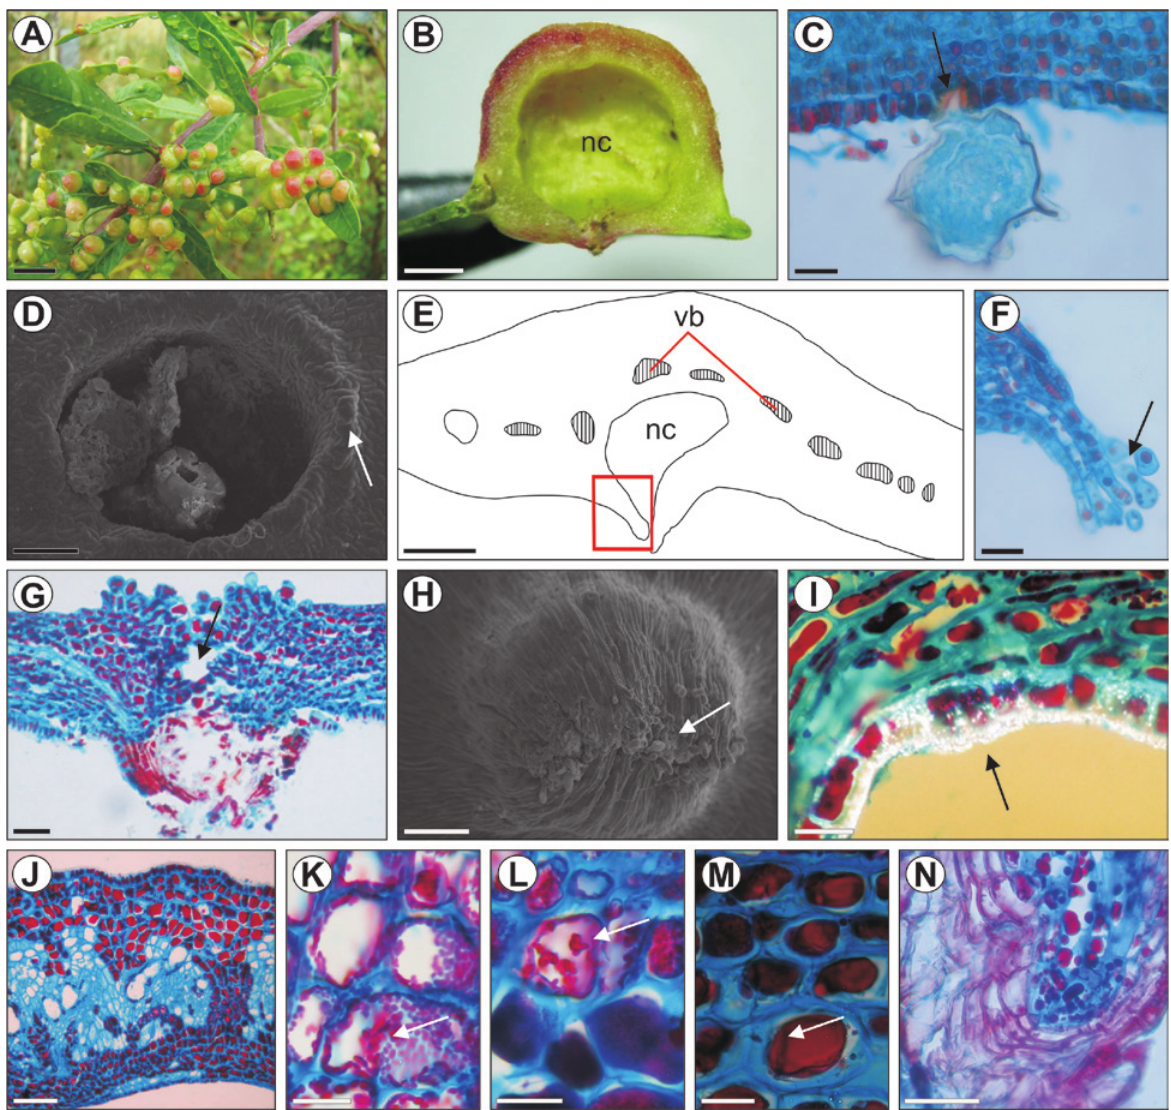
Fig. 2 - Development of the galls of Calophya duvauae on the leaves of Schinus polygamus : A) Shoot with several galls; B) Cross section of a mature gall, showing the large nymphal chamber (nc); C) Egg inserted (arrow) in the abaxial epidermis; D) Evagination of leaf tissues around insect body, under scanning electron microscopy (arrow); E) Diagram of a cross section of the gall during the growth and developmental phases, showing the nymphal chamber and position of the vascular bundles; F) Detail (red rectangle in E) of the trichomes at the opening of the gall (arrow); G) Detail of the region of the gall opening, with lignified trichomes (arrow); H) Trichomes in the region of the opening (arrow), scanning electron micrograph; I) Abaxial epidermis near the opening, with calcium oxalate crystals (arrow); J) Adaxial region of the gall, highly vascularized and with parenchyma cells containing phenolics (reddish); K-M) Progressive accumulation of phenolics in the gall cortex (arrows); N) Cicatrization tissue (suber) in the opening of a senescent gall. nc = nymphal chamber; vb = vascular bundle. Bars = 1 cm, 1 mm, and 20, 100, 150, 25, 50, 100, 20, 100, 20, 20, 20, 40 µm,